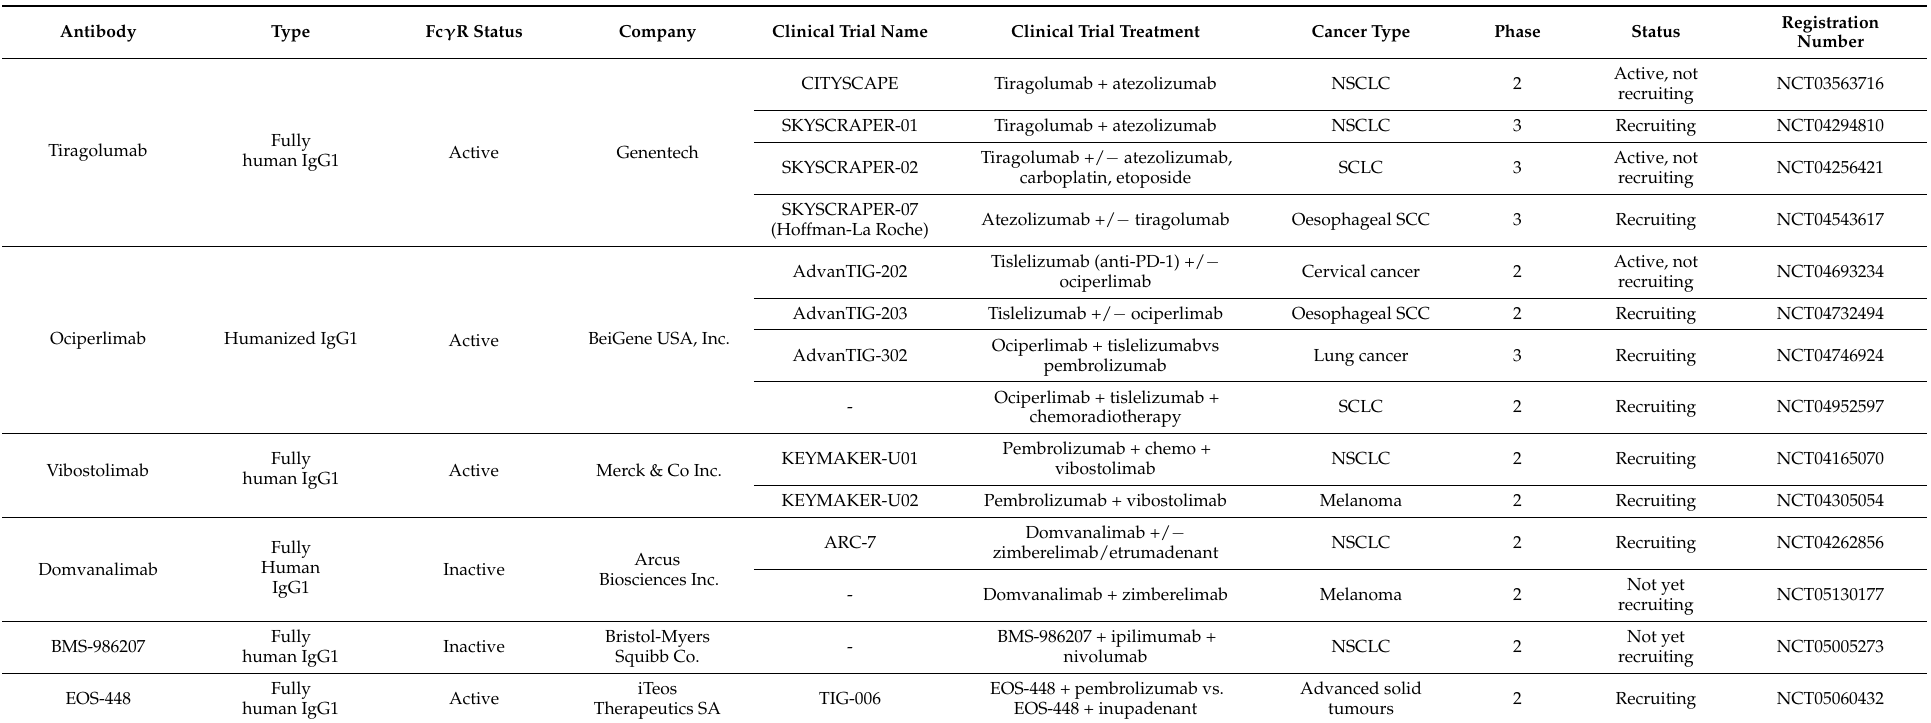
Table 2. Anti-TIGIT monoclonal antibodies in phase II/III of clinical